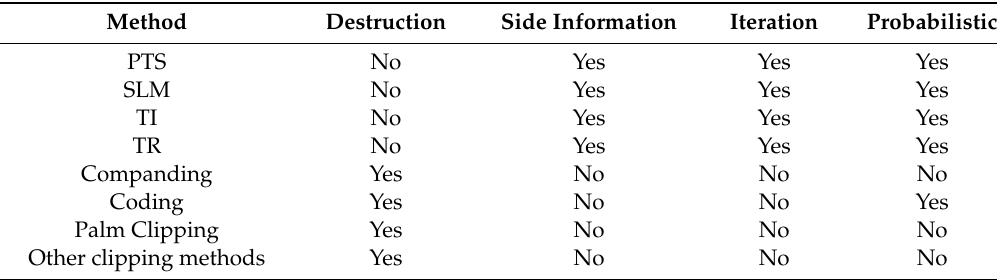
Table 6. Comparative study of the PAPR reduction methods with the proposed method. TI: Tone Injection, TR: Tone